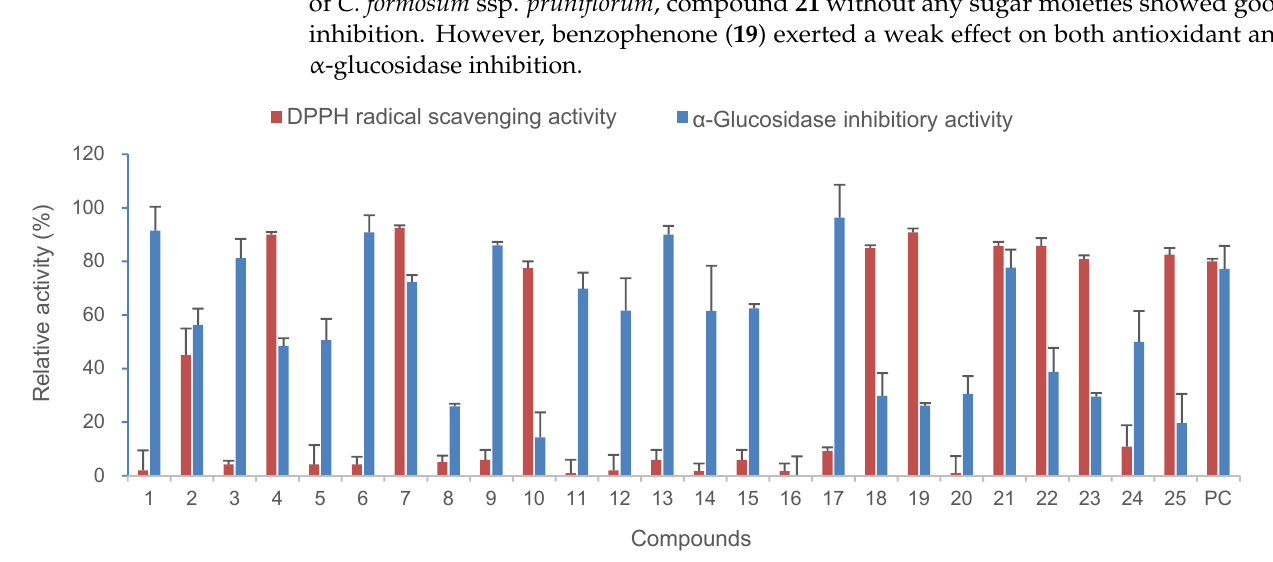
Figure 3. Antioxidant and α -glucosidase inhibitory activity of compounds 1 – 25 from C. formosum ssp. pruniflorum.